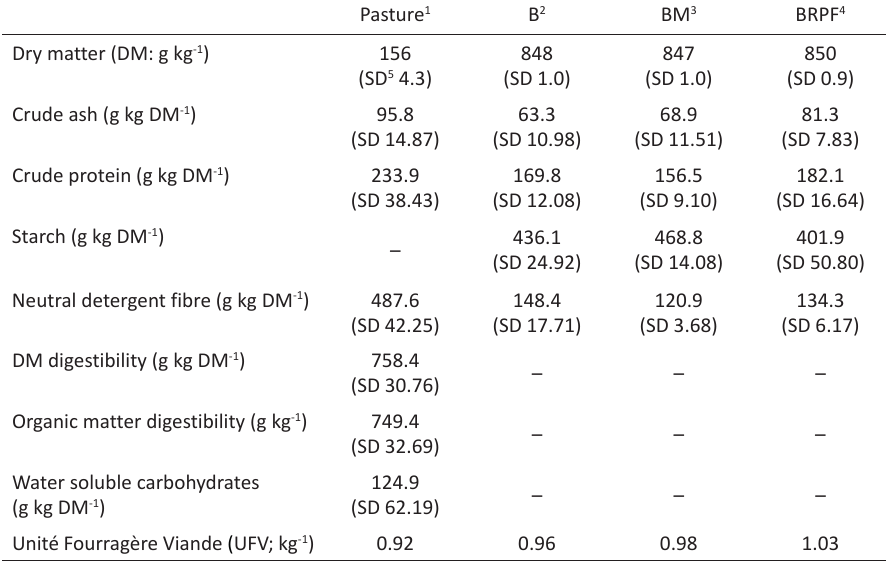
Table 1. Chemical composition of the feed offered during the experimental period Pasture